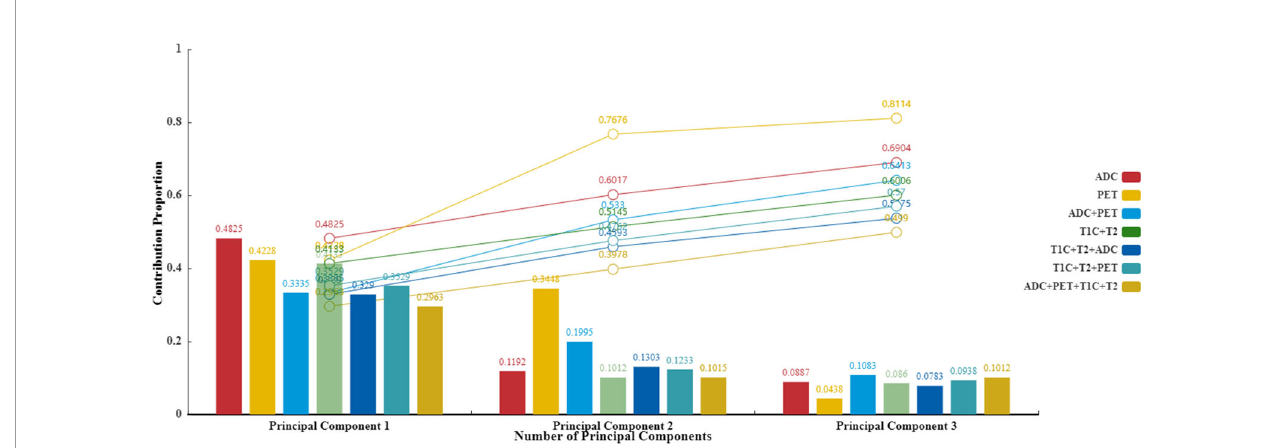
FIGURE 3 | Principal component contribution histogram and cumulative contribution rate line chart.